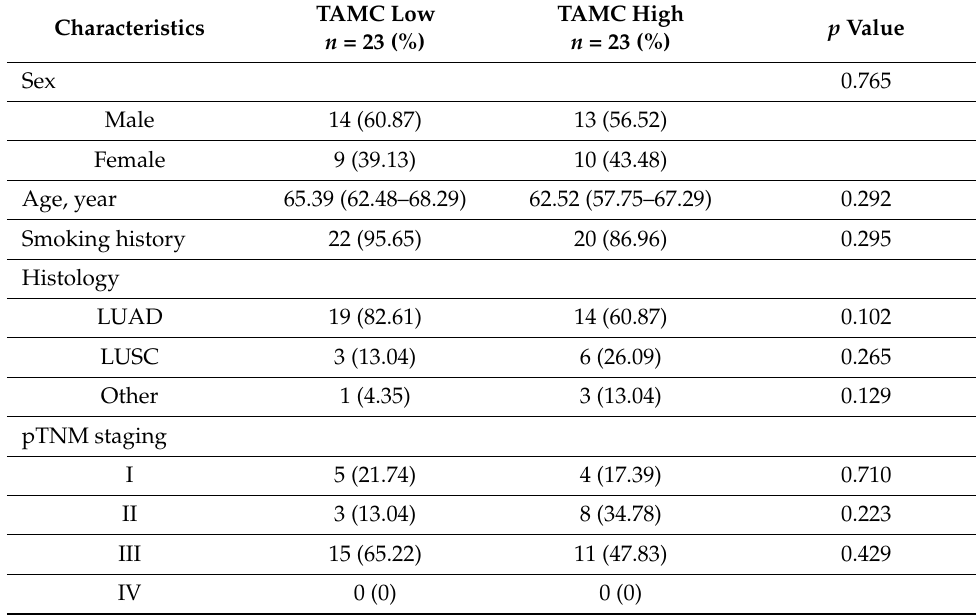
Table 3. TAMC low and TAMC high patient’s